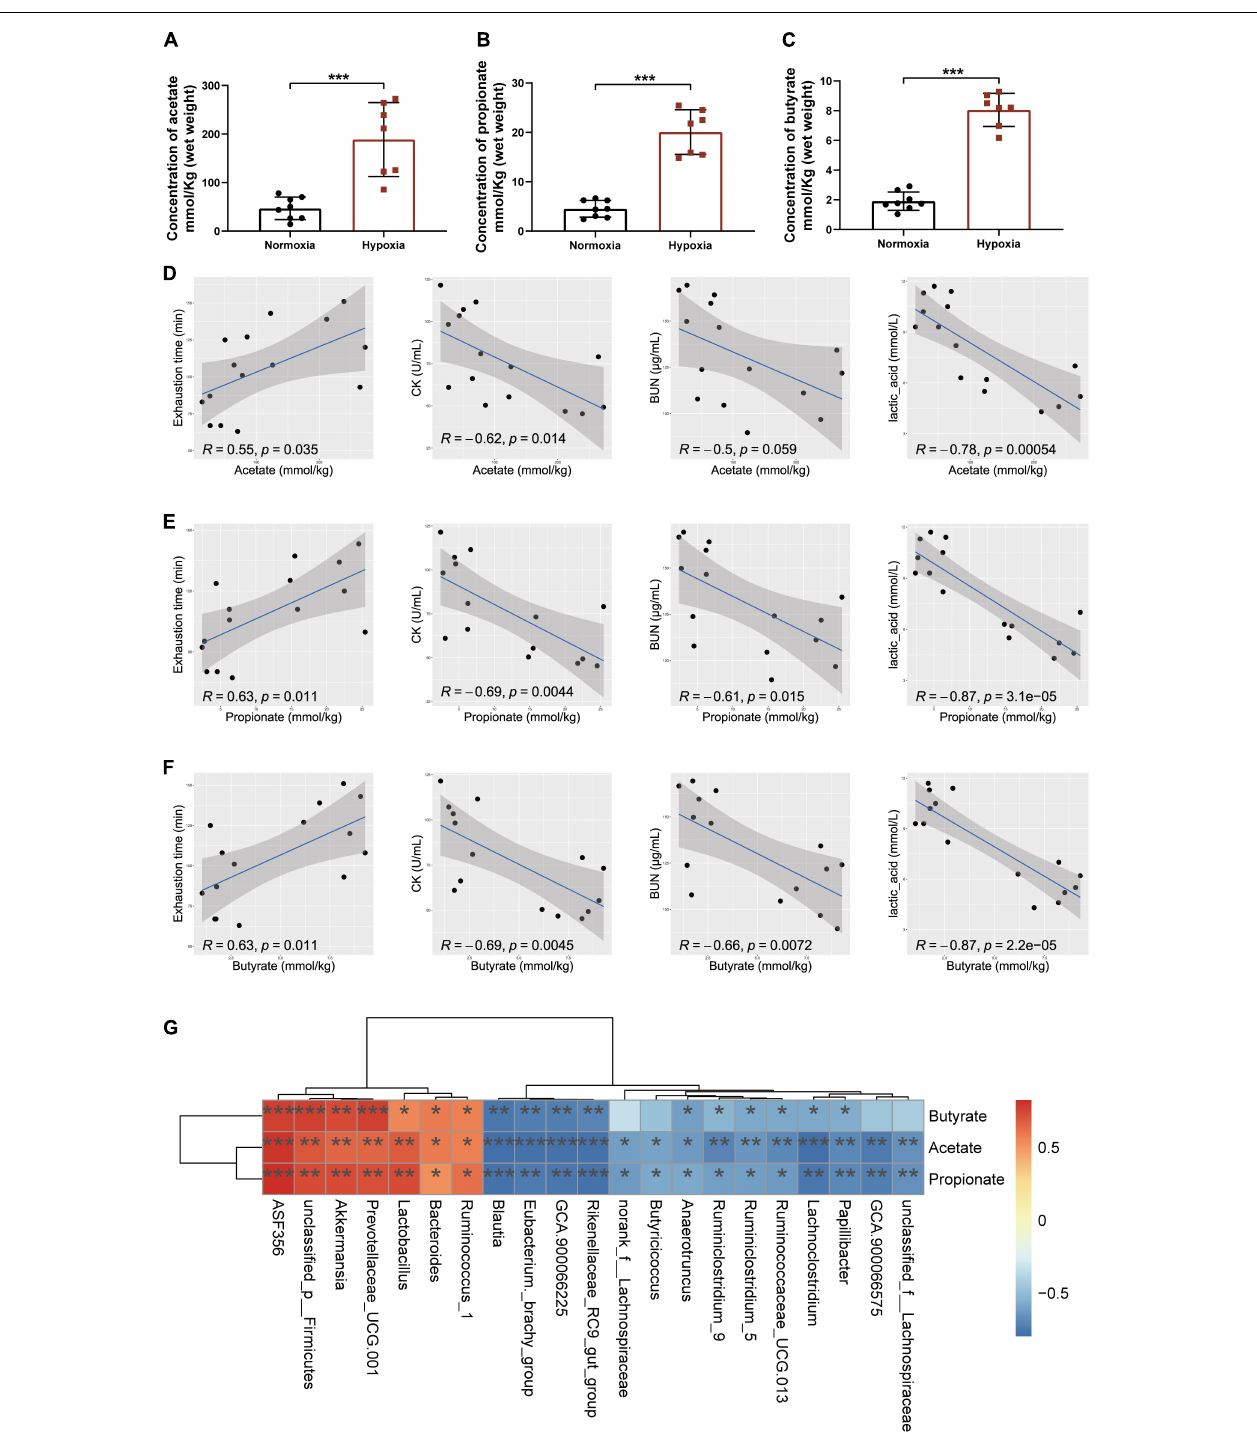
FIGURE 3 | Microbial changes induced by hypoxia exposure regulated SCFAs production. The contents of acetate (A) , propionate (B) , and butyrate (C) were measured by GC–MS in cecal contents. Data are presented as means ± SD. (D) Plots show the relationship between the content of acetate and exhaustion time, CK, BUN, and lactic acid, represented as a smoothing spline with a 95% confidence interval (shaded region). (E) Plots show the relationship between the content of propionate and exhaustion time, CK, BUN, and lactic acid, represented as a smoothing spline with a 95% confidence interval (shaded region). (F) Plots show the relationship between the content of butyrate and exhaustion time, CK, BUN, and lactic acid, represented as a smoothing spline with a 95% confidence interval (shaded region). (G) Heatmap of Pearson’s correlation analysis between the key gut microbial taxa at the genus level and the contents of SCFAs in cecal contents. * p < 0.05, ** p < 0.01, *** p < 0.001. ( A–C , Student’s t -test; D–G , Pearson’s